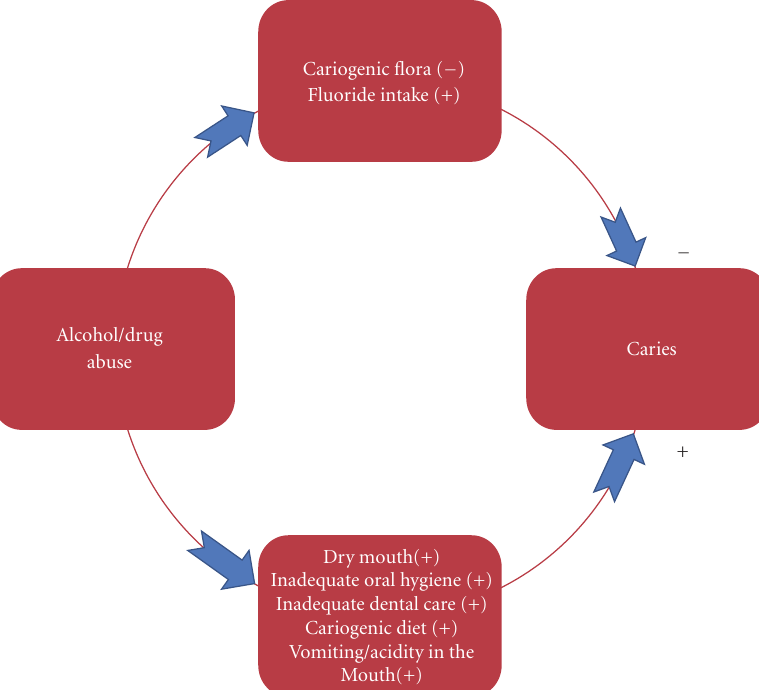
Figure 1: Hypothetical biological model to explain the association between alcohol and drug abuse and dental caries.